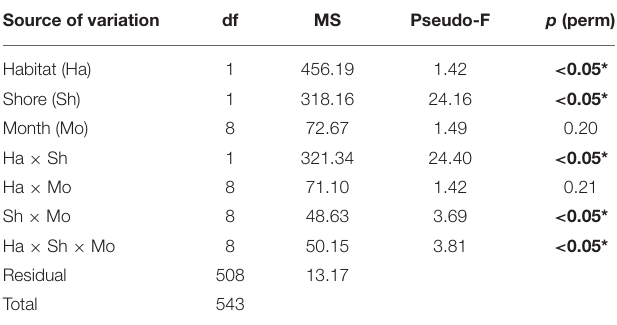
* indicate p < 0.05. Bold values and asterisks indicate significant effects.